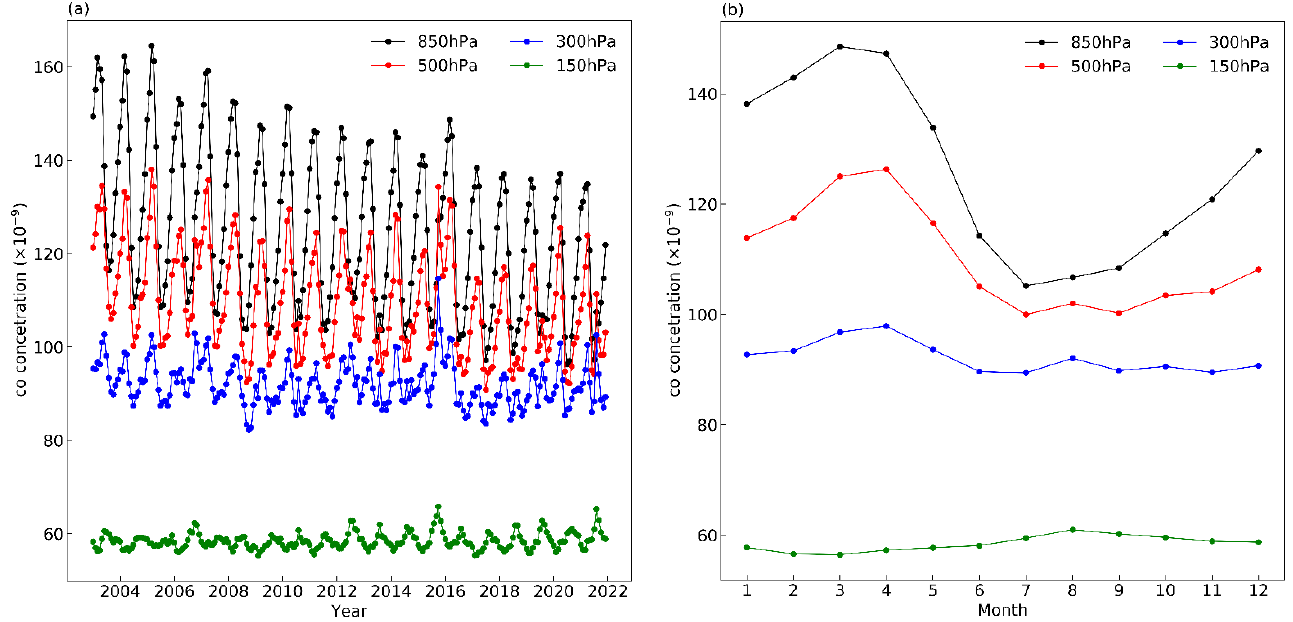
Figure 7. Monthly variation of tropospheric CO concentration in East Asia from 2003 to 2021. ( a ) Change month by month; ( b ) Monthly average change over the years.